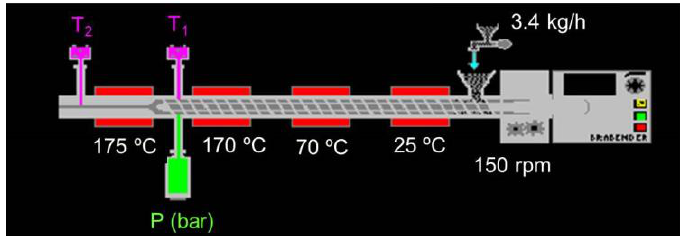
Figure 3. Scheme of conditions used in the extruder.